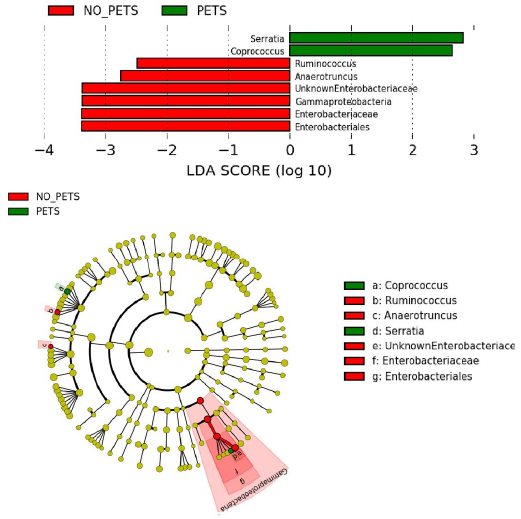
Figure 2. Cladogram representing the taxonomic hierarchical structure of the identified differences between pet owners and non-pet owners using Linear discriminant analysis effect size. Each filled circle represents one phylotype. Red, bacterial taxa statistically overrepresented in non-pet owners; green, bacterial taxa overrepresented in pet owners. Phylum and class are indicated in their names on the cladogram and the order, family, or genus are given in the key.